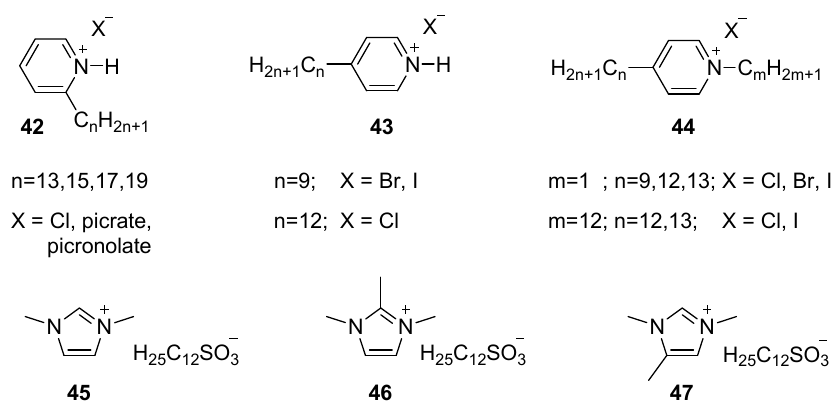
Figure 10. Pyridinium ( 42 – 44 ) and imidazolium-based ( 45 – 47 ) ILC with alternative substitution patterns show that in some cases, small changes in the cation structure are very important for the physical properties, while in other cases small structural changes are allowed.